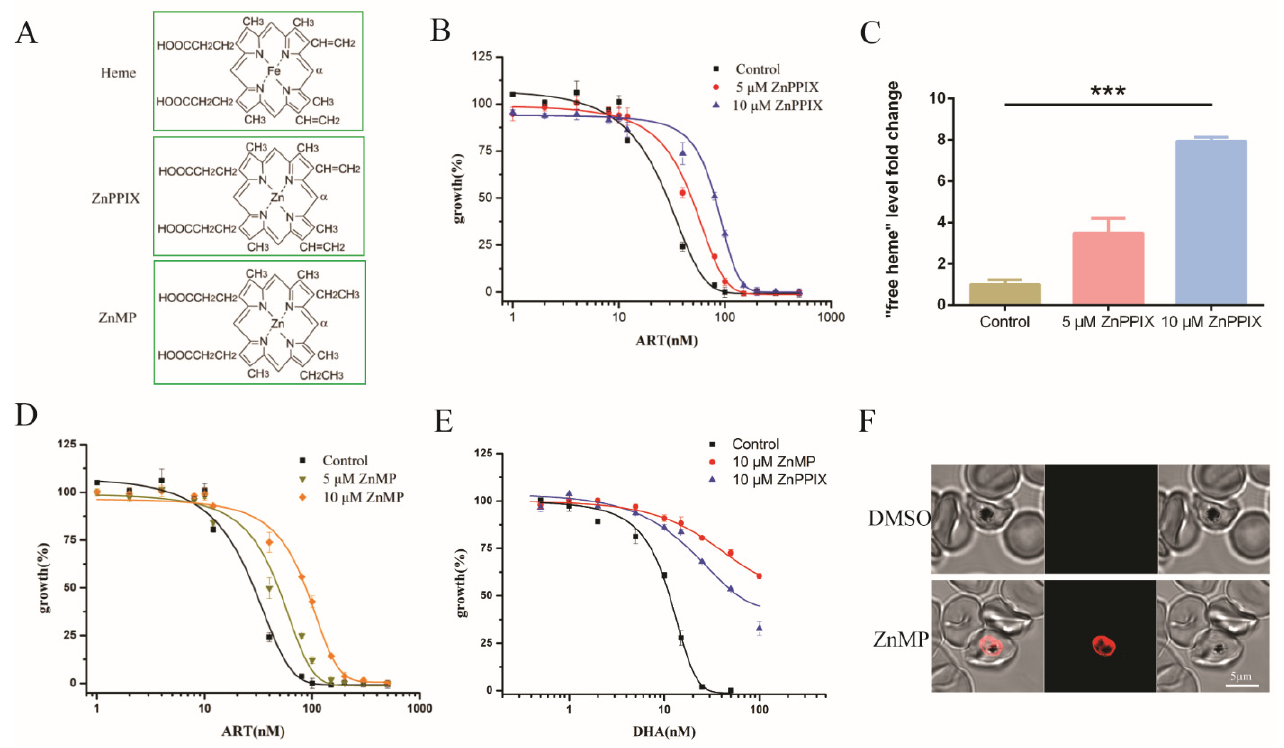
Figure 4. Heme analogues disrupted heme homeostasis and increased EC 50 of artemisinin in P. falciparum . ( A ) Chemical structures of heme, ZnPPIX and ZnMP. ( B ) EC 50 values of artemisinin in P. falciparum were increased by more than twofold in the presence of 10 µ M ZnPPIX. ( C ) ZnPPIX elevated the free heme content by more than sixfold versus the control. ( D ) EC 50 values of artemisinin were increased in the presence of ZnMP. ( E ) ZnPPIX and ZnMP decreased sensitivity of parasites to DHA. Data are mean ± SD of three experiments. ( F ) An amount of 20 µ M ZnMP could efficiently reach into the parasite within an hour. The data were analyzed by GraphPad Prism. *** p -value < 0.0005.